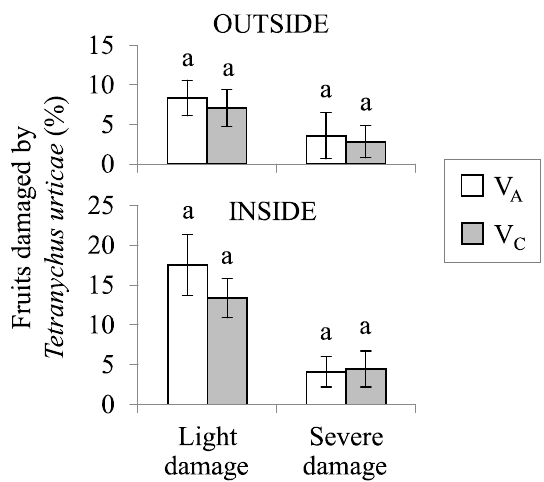
Figure 7. Fruits damaged by Tetranychus urticae (%, mean ± standard error) at two depths of the canopy (outside, inside) and for both treatments (V A : adjusted volume; V C : conventional volume). Different letters above the bars indicate significant differences between V A and V C (LSD test, p < 0.05).